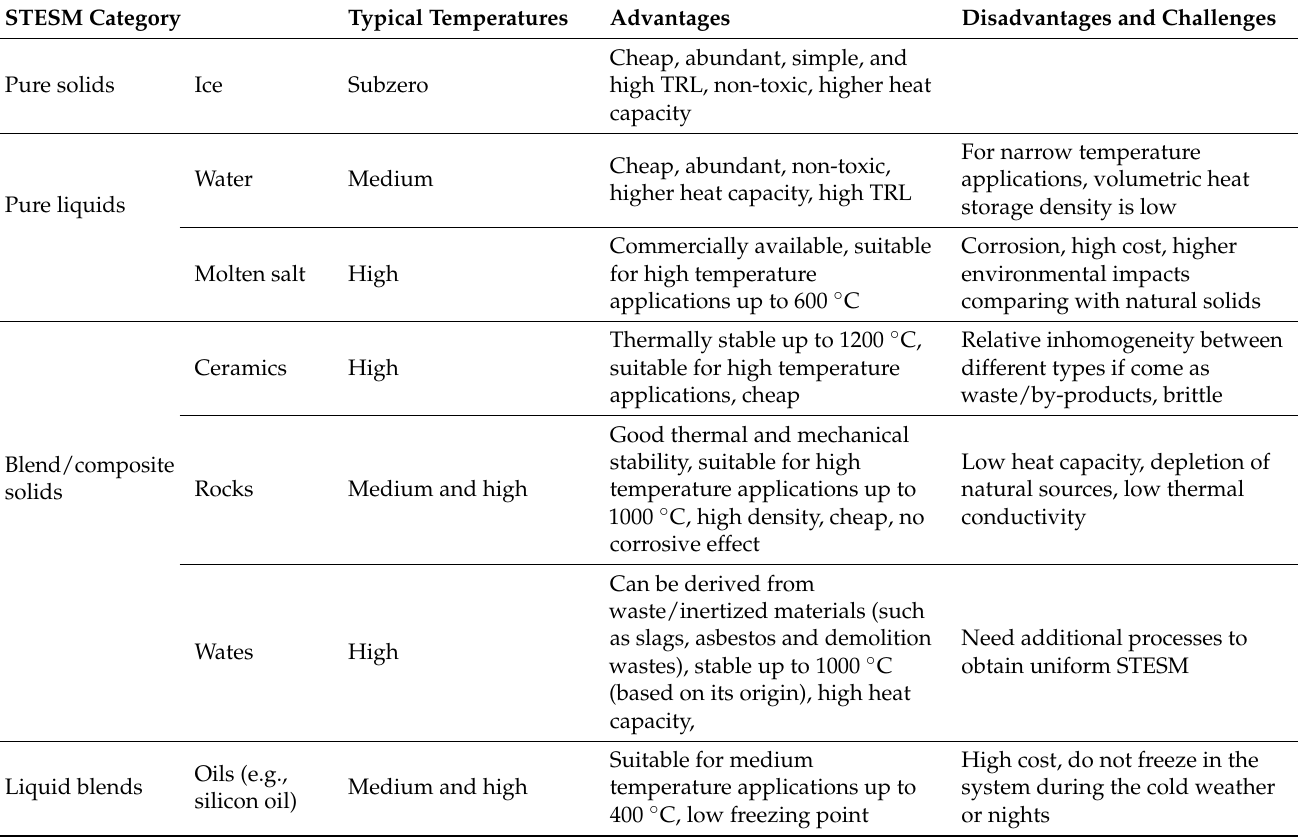
Table 4. Advantages and disadvantages of various STESM categories (here the temperature ranges provided are just indicative but not exclusive. Subzero, medium and high temperatures represent below 0 ◦ C, between ~4–100 ◦ C, and above ~100 ◦ C,